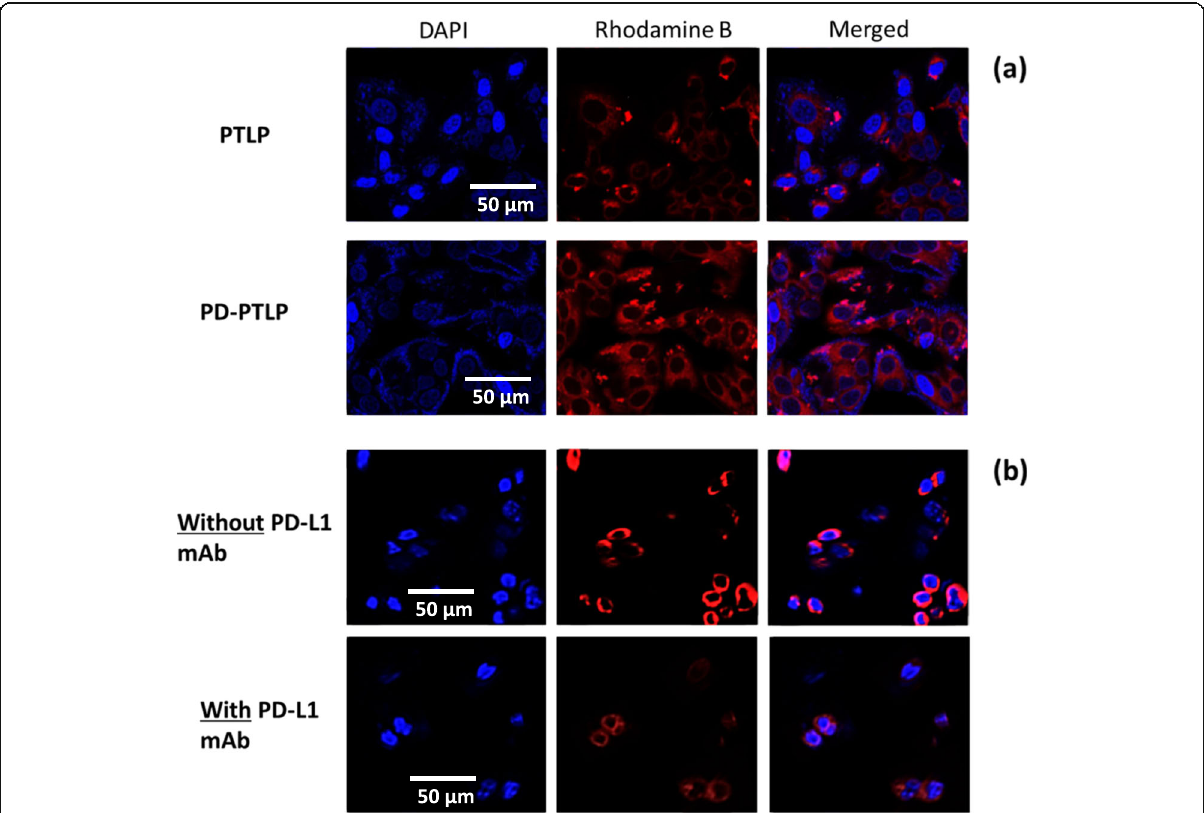
Fig. 3 a Confocal laser scanning microscopy (CLSM) images of SGC7901/ADR cells after incubation with PTLP and PD-PTLP for 3 h; CLSM images of SGC7901/ADR cells pretreated with/without PD-L1 mAb after incubation with PD-PTLP for 3 h. Rhodamine B was used as a fluorescent tracker and DAPI was used to stain the nucleus of the cancer